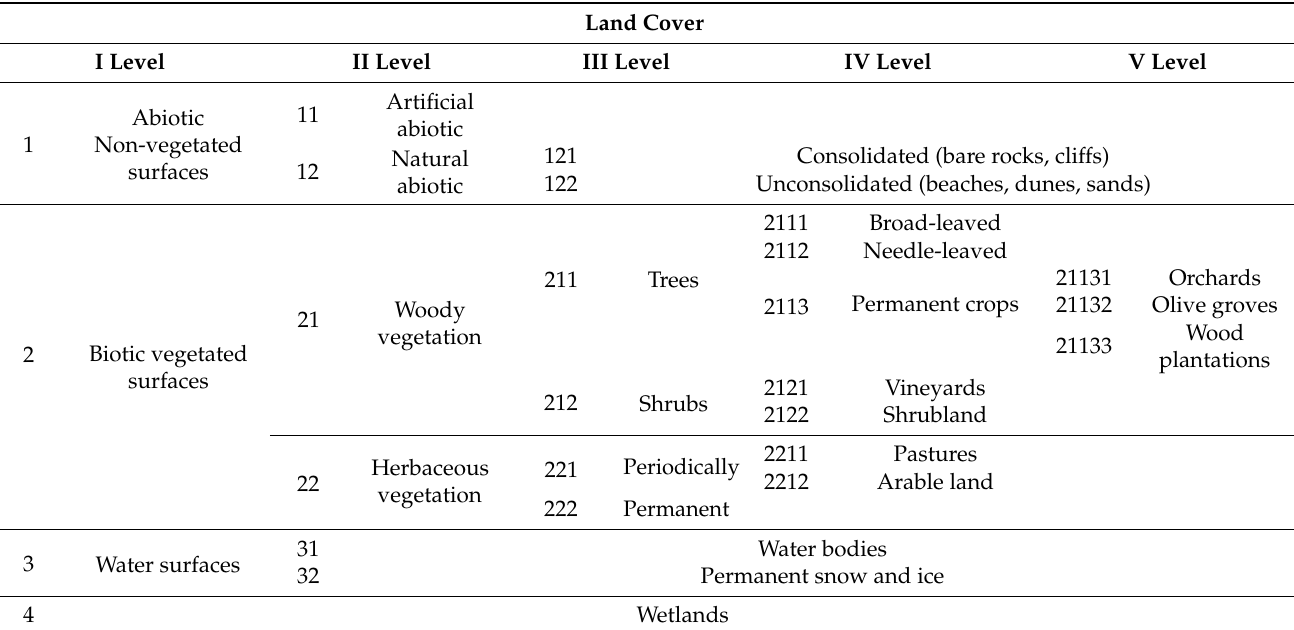
Table 1. Land cover classification